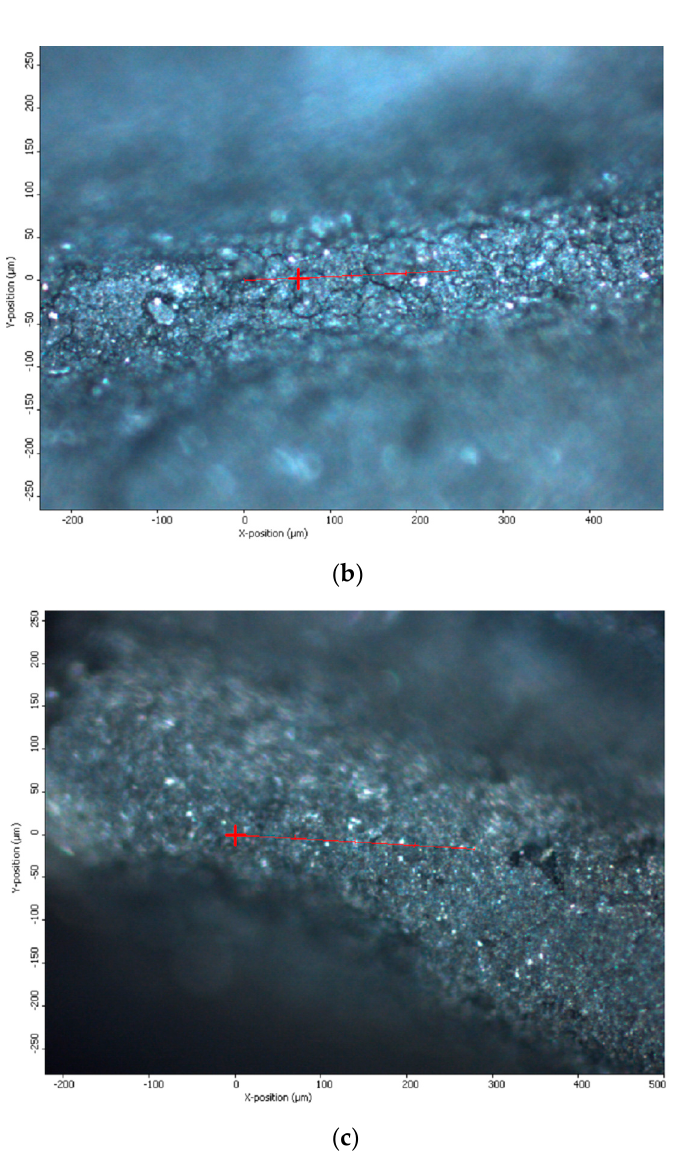
Figure 7. The surface of the catalysts’ assessment with the Raman microscopy ( a ) fresh catalyst, ( b ) used catalyst after T, ( c ) used catalyst after P. The red line is the measured area.